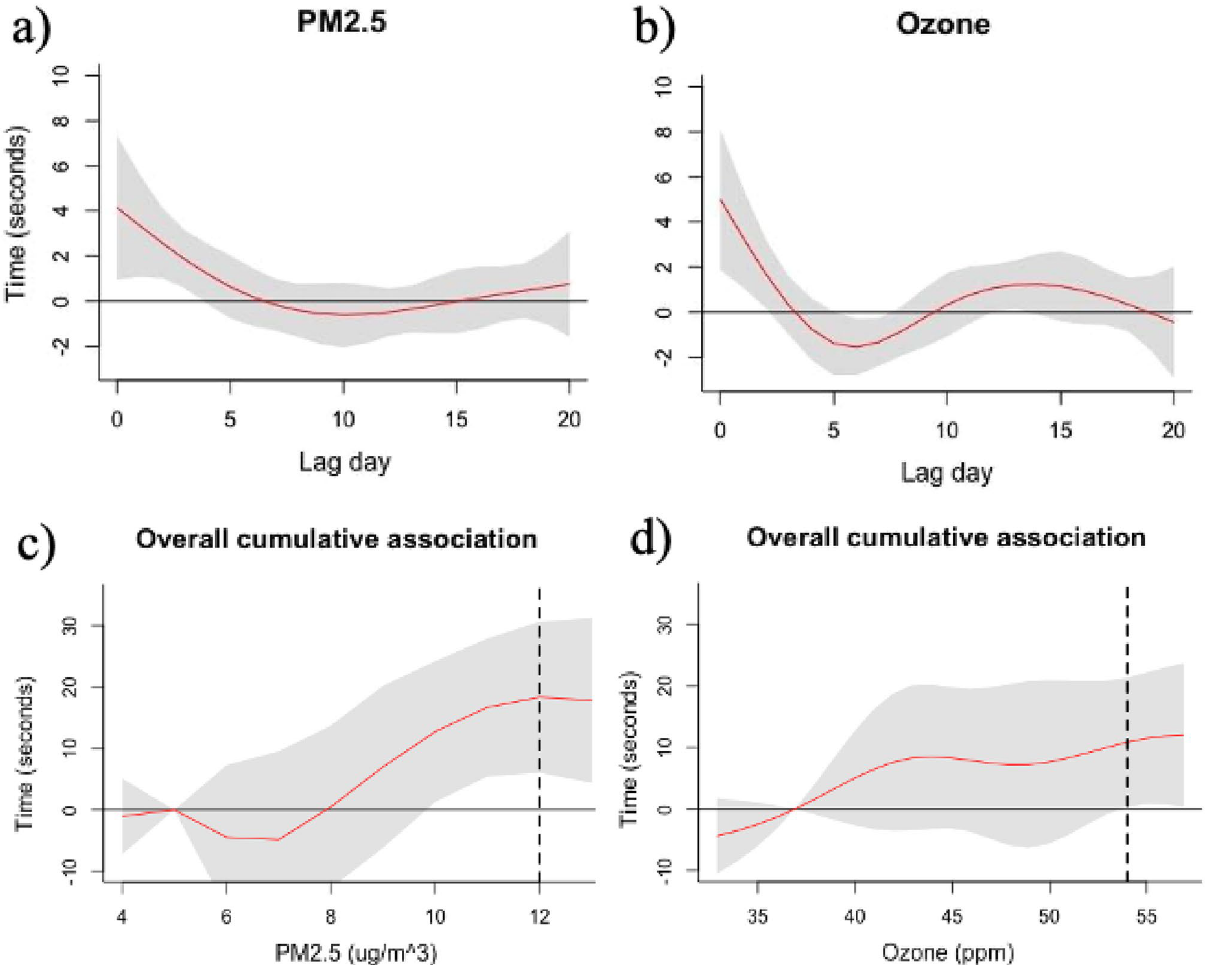
Figure 2. PM 2.5 ( a ) and ozone ( b ) lag-response relationship when comparing our reference levels: 20th percentile exposure with 80th percentile exposure over a 21-day training period (red line) with 95% confidence intervals (grey). Cumulative association of PM 2.5 ( c ) and ozone ( d ) on race performance (seconds) over the 21-day training period (red line) with 95% confidence intervals (grey) and AQI good threshold (dashed black line). Software: R version 4.0.3 dlnm version